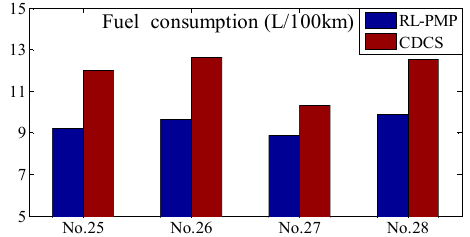
Figure 25. The fuel consumptions of the HIL verification.